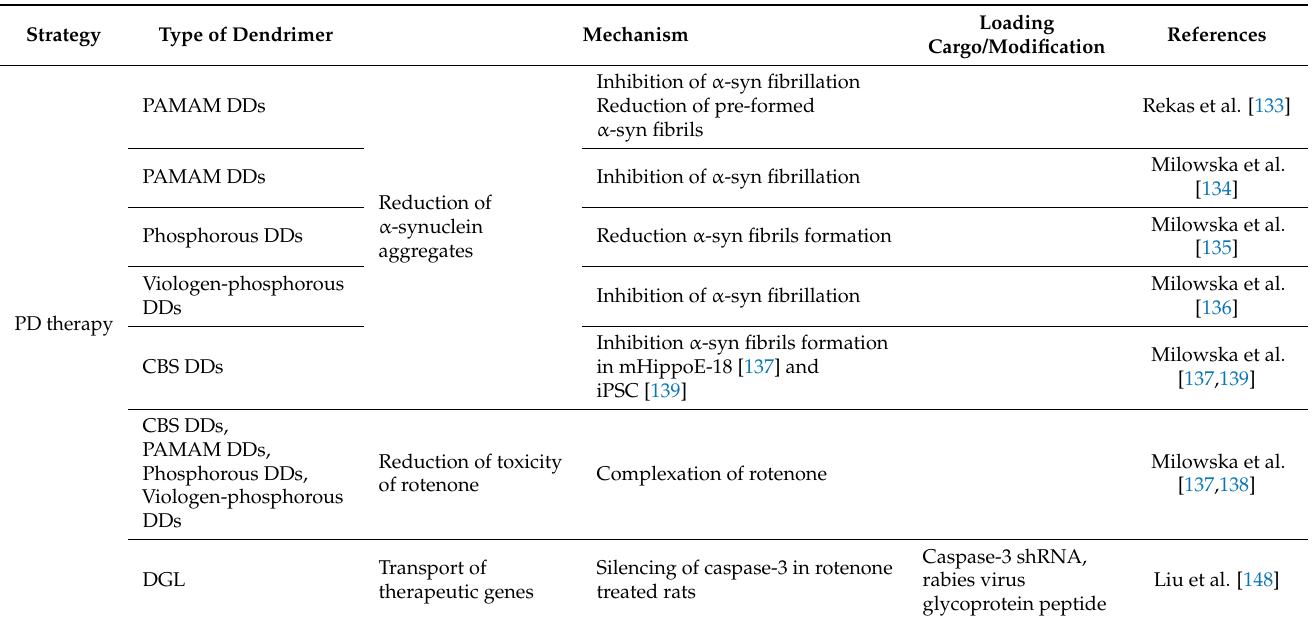
Table 2. DDs for PD therapy and diagnosis. Abbreviations: CBS (carbosilane) DDs (dendrimers), α -syn ( α -synuclein), DGL (dendrigraft poly-L-lysines), hGDNF (human glial-derived neurotrophic factor), AR (adenosine receptor), mHippoE-18 (embryonic mouse hippocampal cell line), GATG (gallic acid-triethylene glycol) PLL (poly-L-lysine), DGL (dendrigraft poly-L-lysines), NFT (neu- rofibrillary tangles), BACE1 ( β -amyloid converting enzyme 1), PEG (polyethylenglicol), AChE